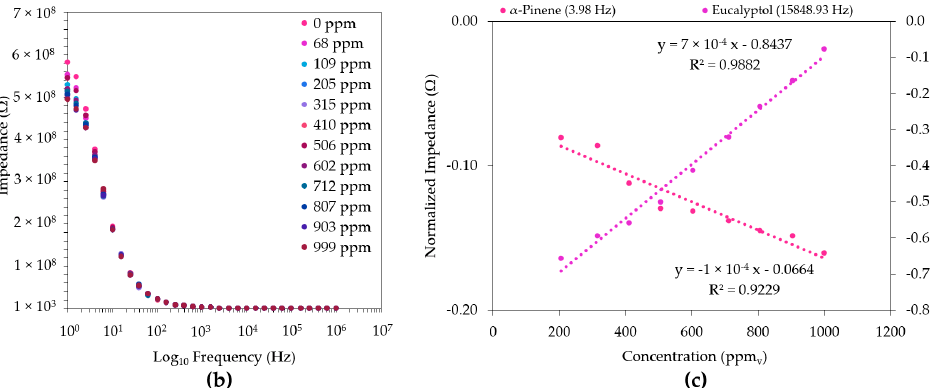
Figure 4. Impedance spectra of the ZnO (100% O 2 )-based film sensor obtained for eucalyptol ( a ) and α -pinene ( b ), and normalized impedance ( Ω ) spectra at a fixed frequencies (eucalyptol, 15,848.93 Hz; α -pinene, 3.98 Hz, ( c ) for the measurement of different concentrations in air. The average and standard deviations of the respective impedance data of the duplicates were used for the normalization (Supplementary Materials, Tables S6 and S14).